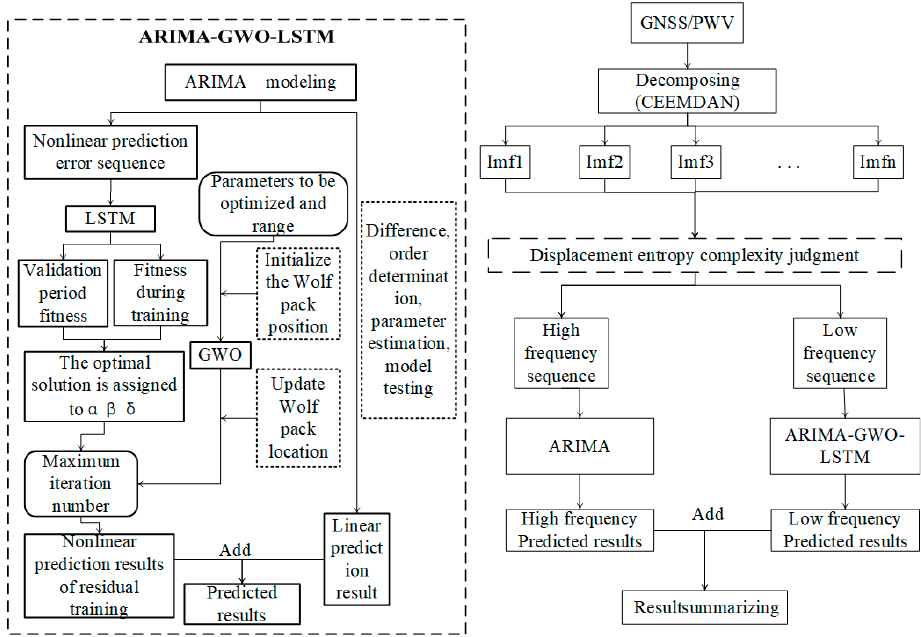
Figure 3. Workflow of the composite